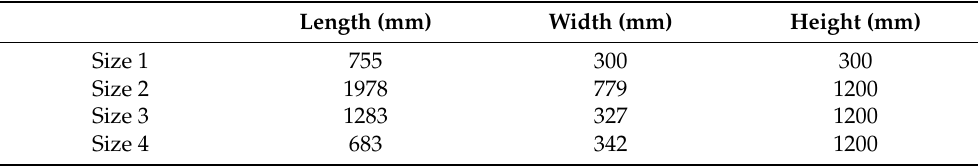
Table 1. Dimensions of tanks used in the study. Length (mm) Width (mm) Height